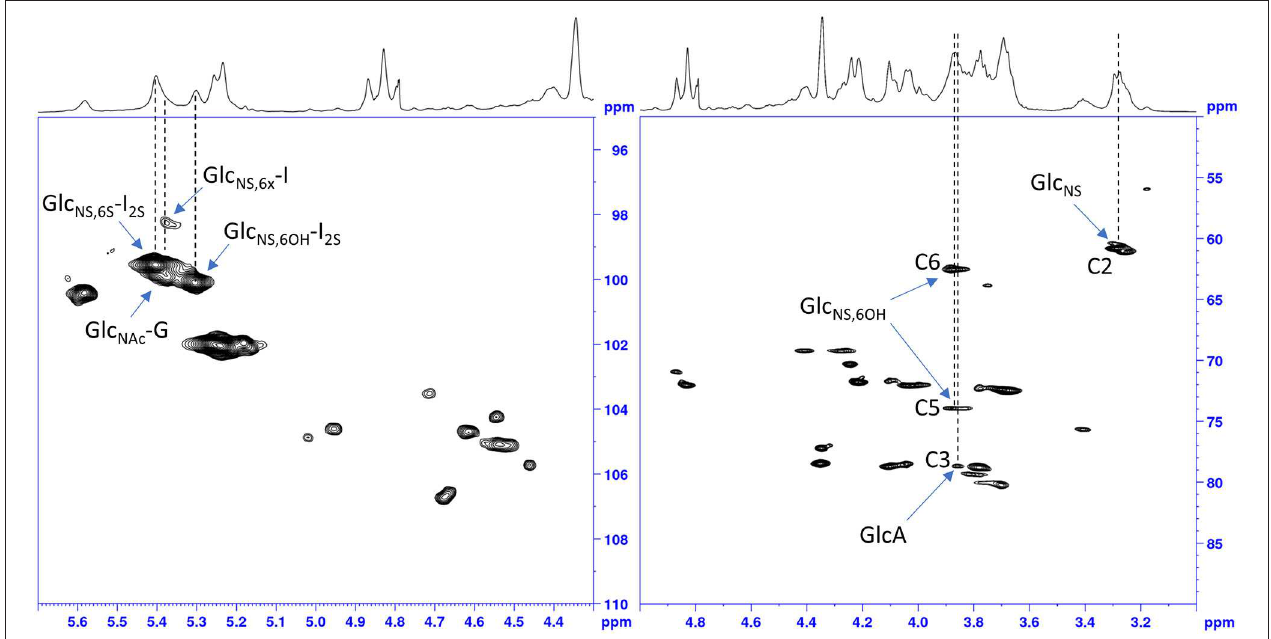
FIGURE 2 | HSQC spectrum of a bovine heparin. Expansions of the anomeric signals region (left) and of ring signals (right) .